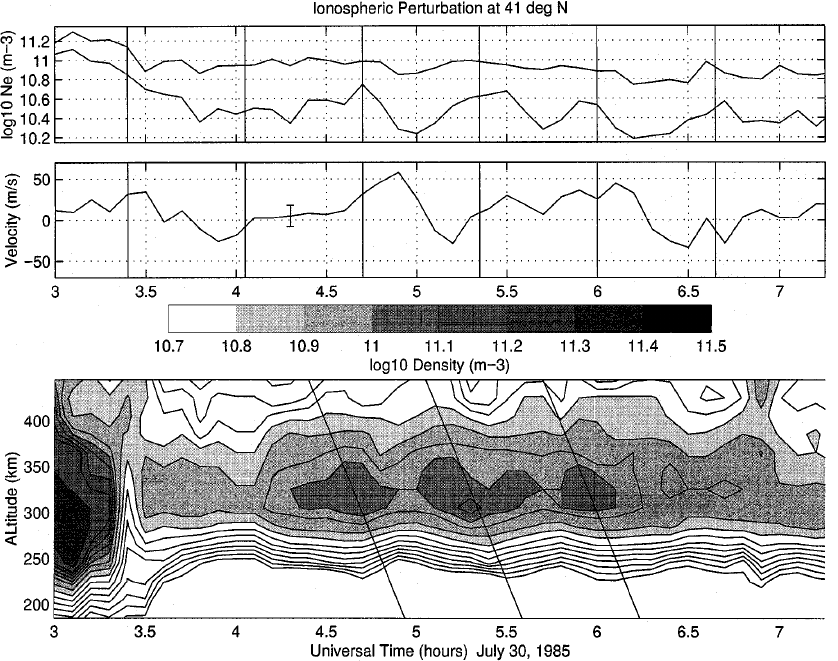
Fig. 2. Temporal variation of the density at two altitudes, 300 km and 260 km, ob- served with the radar is shown in the upper panel . Vertical lines beginning at the time of the Spacelab-2 OMS engine burn (03:22 UT) and repeated with 40-min period highlight the quasi-periodic variation of the density at the lower altitude. Velocity data for 41 (cid:176) latitude and 300 km altitude are shown in the middle panel . In the lower panel , iso-density contours with overscribed fiducial lines delineate the downward phase progression of the density enhancements. Density peaks were observed to descend 200 km in altitude in 1460 s and to repeat with